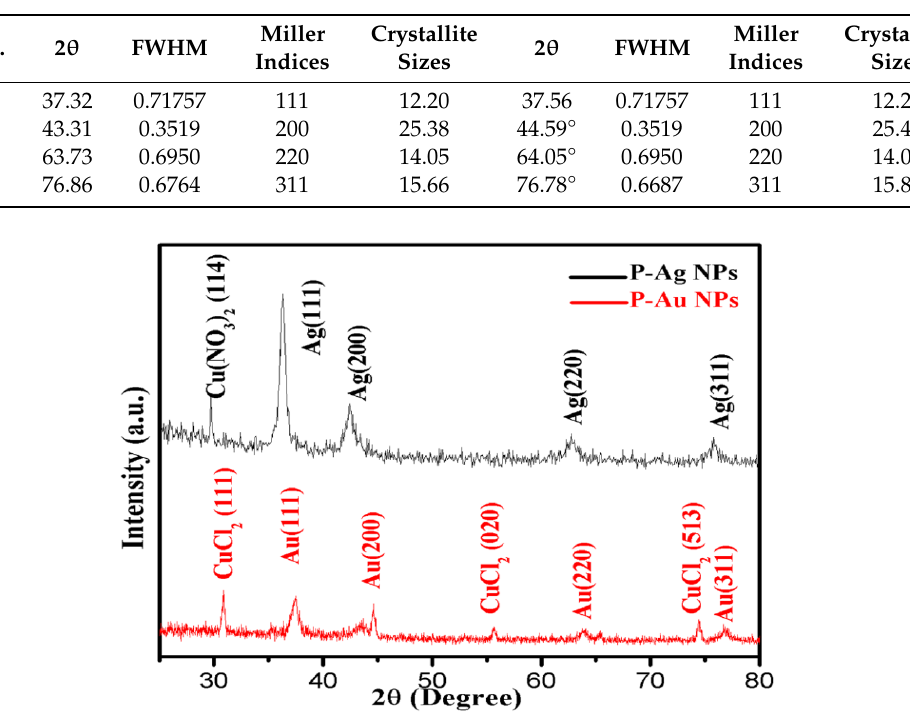
Table 1. Crystallite size of Ag NPs and Au NPs.